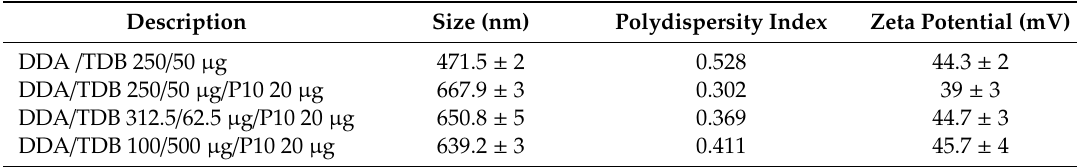
Table 1. Characterization of liposomal